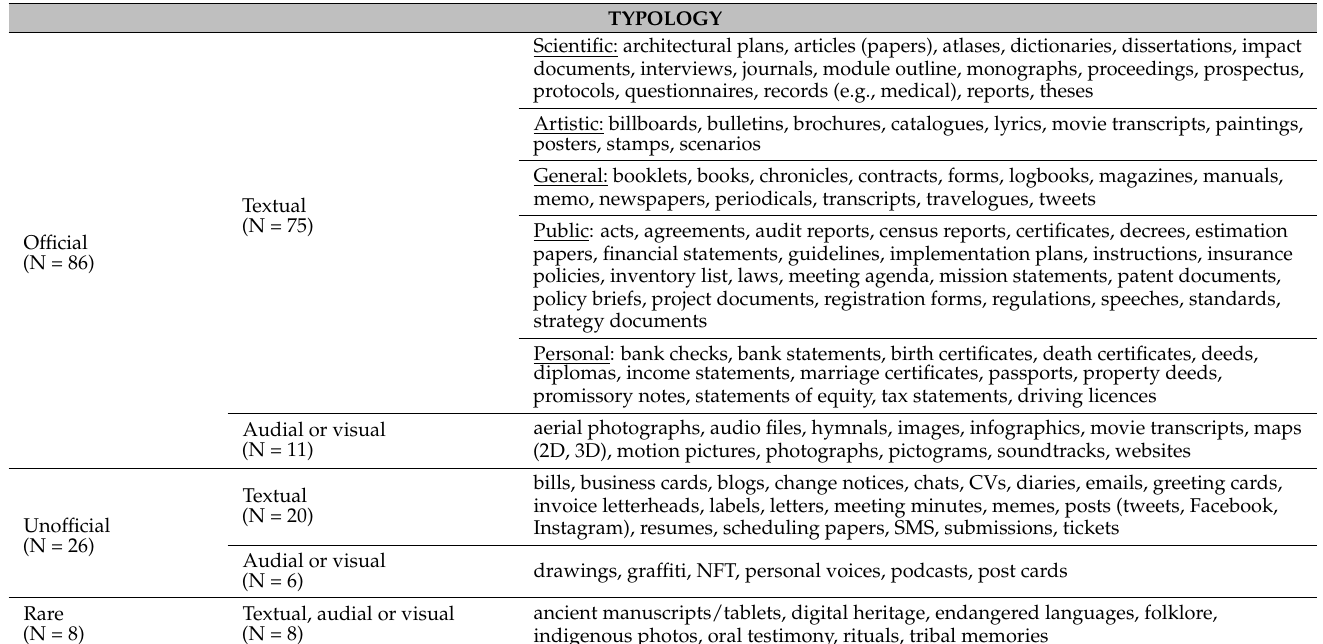
Table 2. Classification of documents and associated